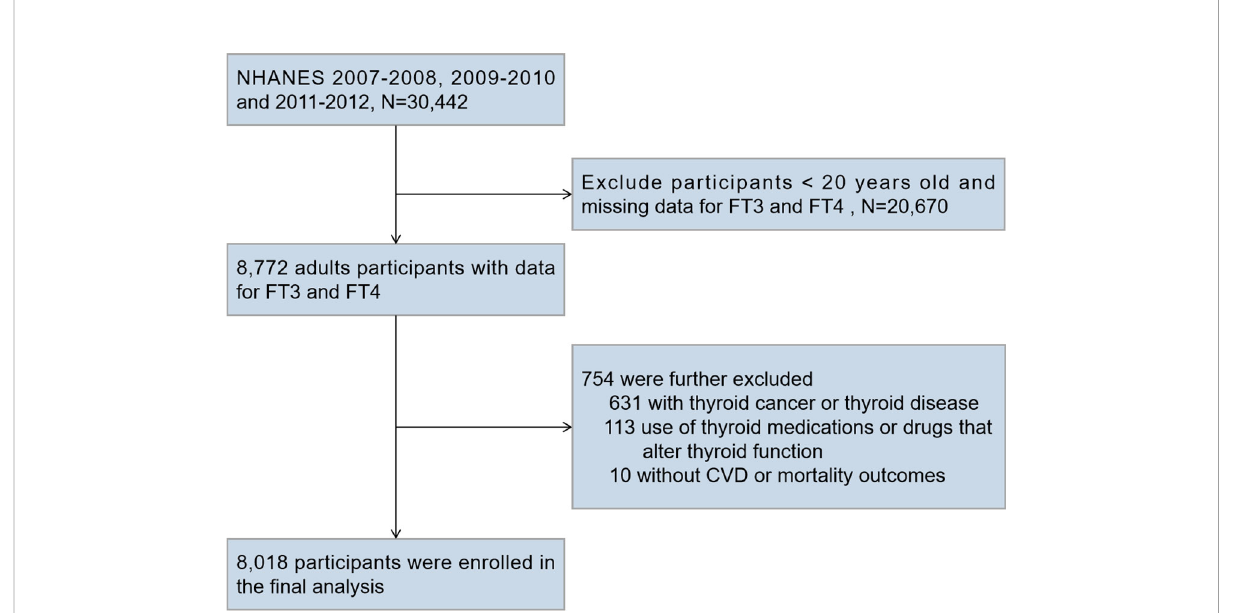
FIGURE 1 Flow Chart for Subject Selection. NHANES, National Health and Nutrition Examination Survey; FT3, free triiodothyronine; FT4, free thyroxine; CVD, cardiovascular